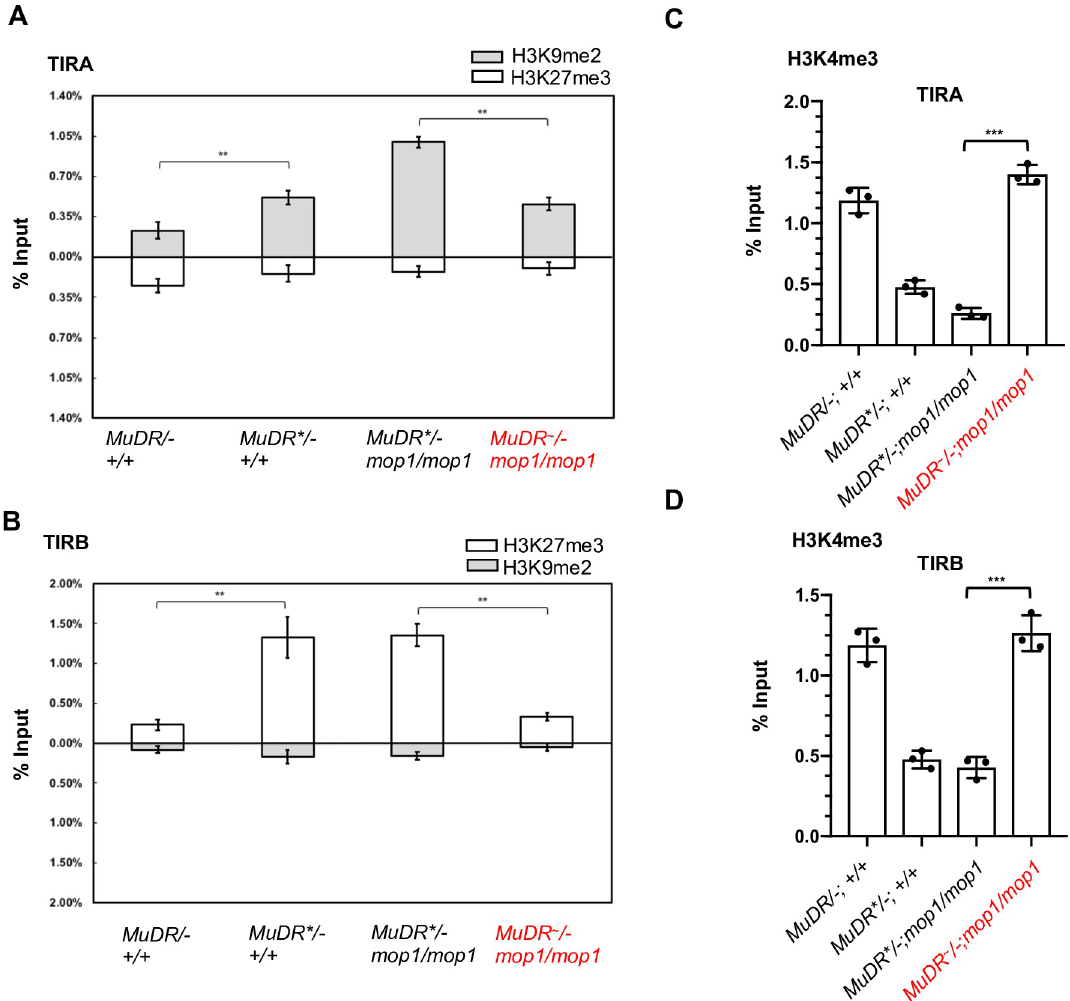
Fig 4. ChIP-qPCR analysis of histone marks TIRA and TIRB under heat stress. Relative enrichment of H3K9me2 and H3K27me3 at TIRA (A) and TIRB (B) in leaf 3 of plants of the indicated genotypes. (Relative enrichment of H3K4me3 at TIRA (C) and TIRB (D) in leaf 3 of plants of the indicated genotypes. qPCR signals were normalized to Copia and then to the value of input samples. MuDR � refers to a silenced MuDR element. MuDR ~ refers to a reactivated element. Red text indicates a sample that has been heat-treated. Error bars indicate mean ± standard deviation (SD) of the three biological replicates. �� P < 0.01; ��� P <